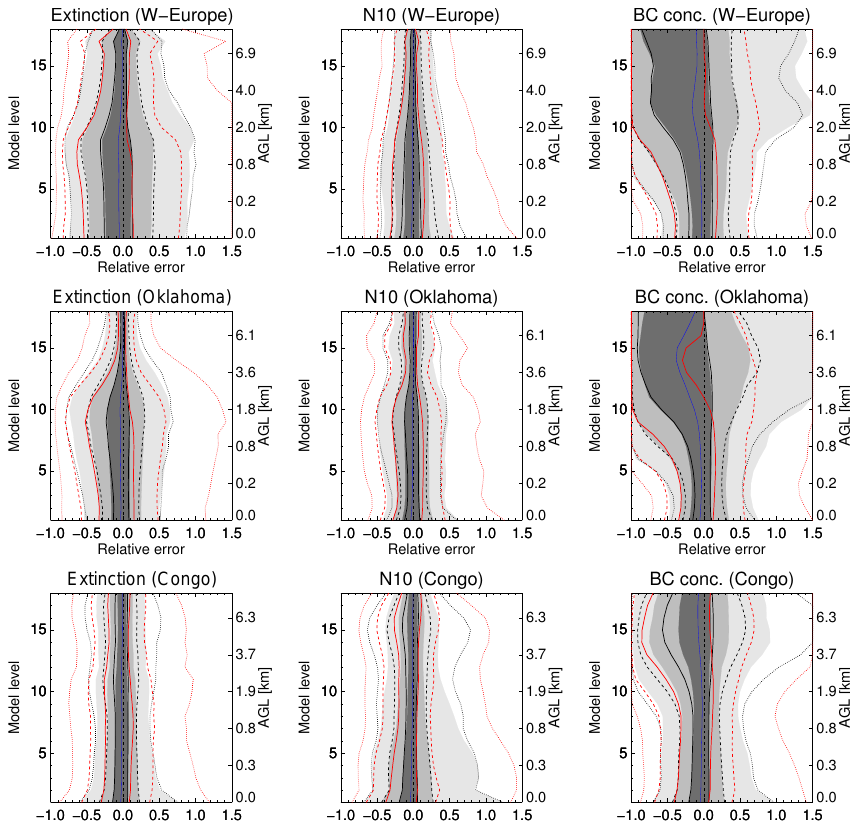
Figure 21. Relative spatial sampling error (for measurements during horizontal legs of a flight campaign) as a function of model level (left vertical axis) and altitude above ground level (a.g.l., right vertical axis) for extinction, N10 and black carbon concentrations. The grey shaded error ranges are for north–south flights. Similar error ranges for east–west flights are shown in black lines. The results of Fig. 10 are also shown in red lines. The usual interquantile ranges (cid:49)q 50 (solid), (cid:49)q 82 (dashed) and (cid:49)q 96 (dotted) are shown. Further explanation in Sect.